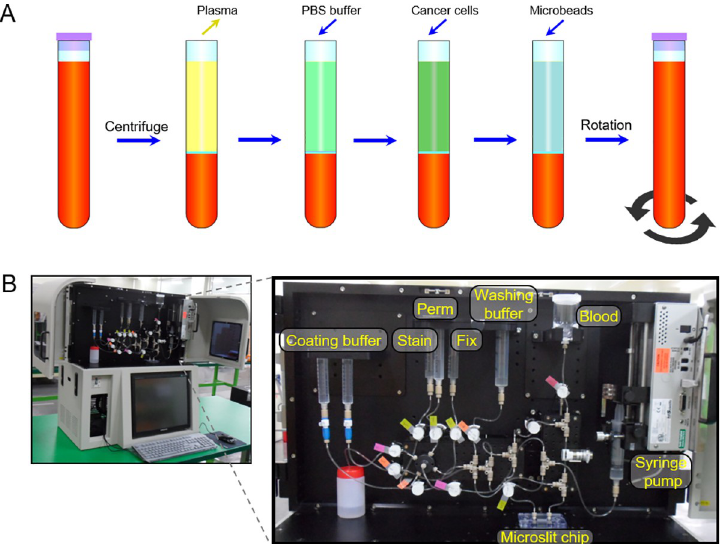
Fig 2. Sample preparation process and the automated CTC isolation system. ( A ) Blood sample preparation. Whole blood is centrifuged after which the blood plasma is removed. PBS buffer is added and then cancer cells are added. To facilitate the capture of the cancer cells in the chip, microbeads are added. Finally, the blood and additions are mixed by rotation. ( B ) Automatic set-up. All tubes connected to individual reservoirs were opened and closed with solenoid valves, while the blood reservoir also includes a shaker. The preprocessed sample was inserted to the blood reservoir and then microfluidic isolation and staining processes were conducted by just one